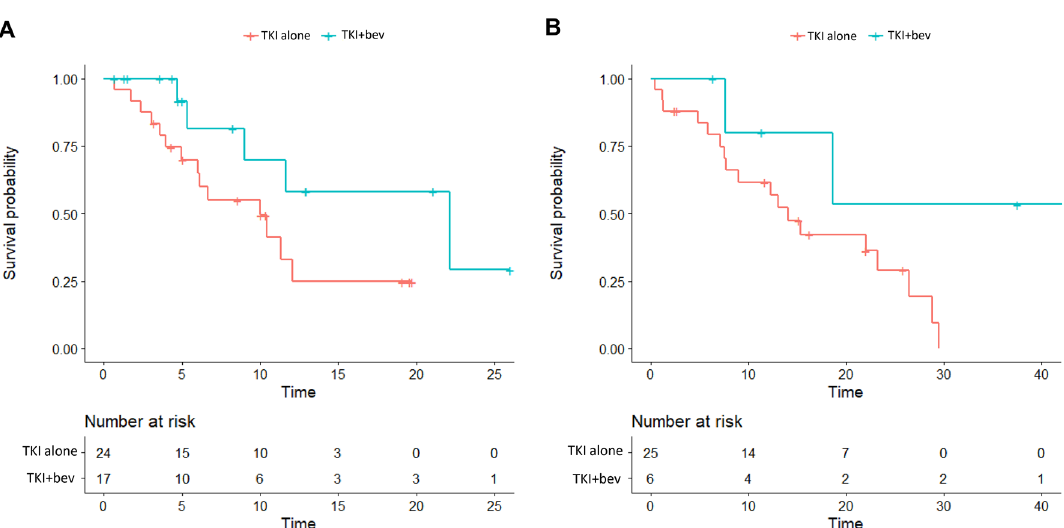
Figure 3. ( A ) OS of EGFR-TKI plus bevacizumab and EGFR-TKI monotherapy by the baseline status of brain metastasis ( B ) Cumulative incidence of systemic progression without death (red) and CNS progression alone without death (black) between EGFR-TKI plus bevacizumab and EGFR-TKI monotherapy groups in patients with baseline brain metastasis. bev bevacizumab, BM brain metastasis, TKI tyrosin kinase inhibitor.